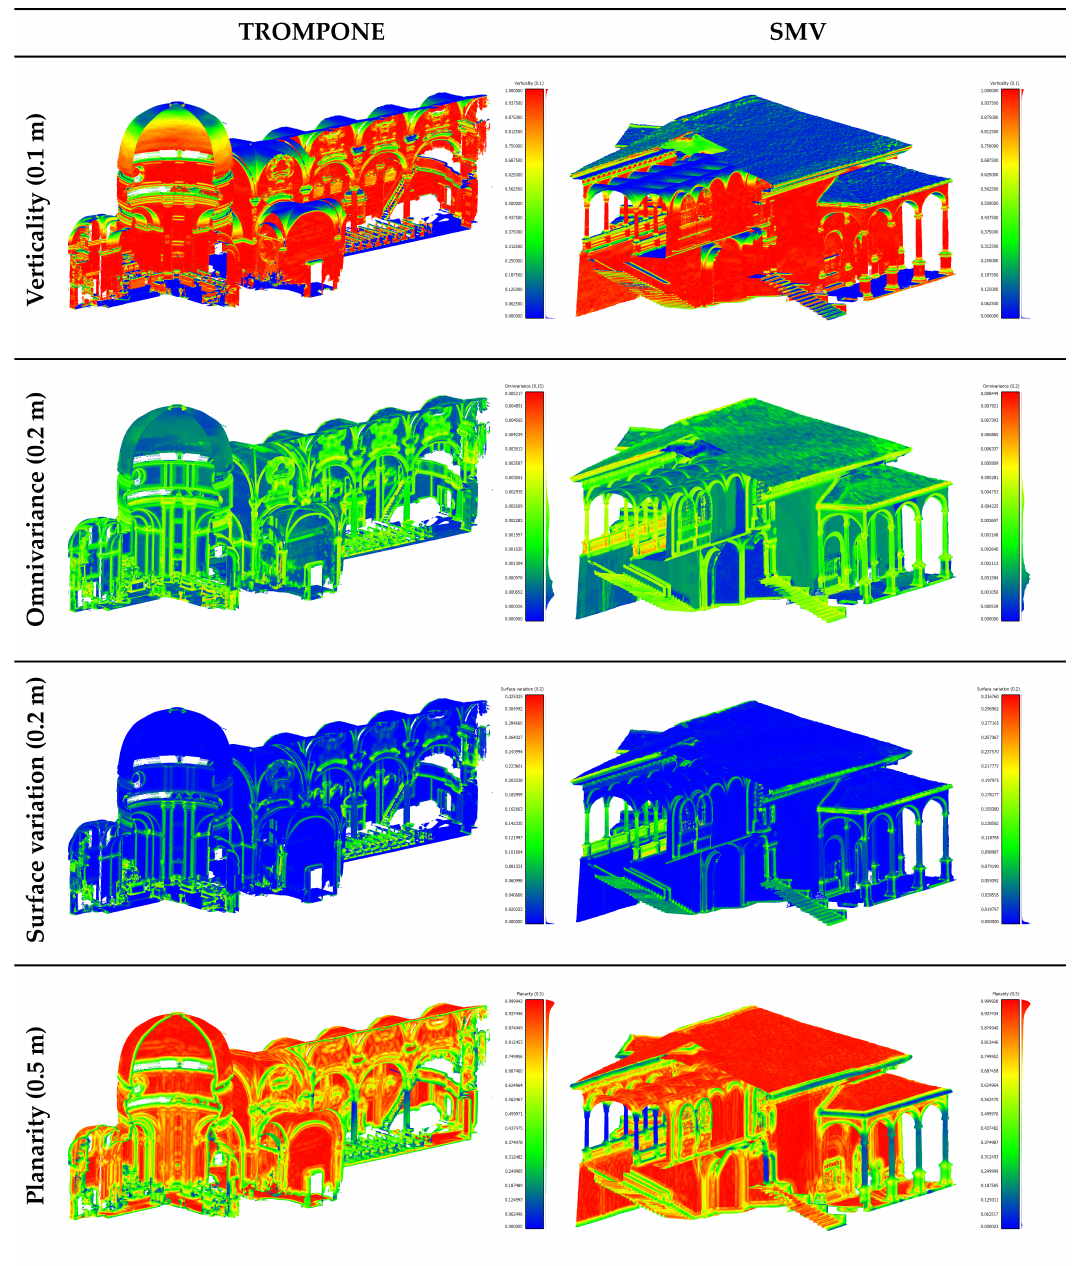
Figure 2. Three-dimensional features used to train the ML and DL classifiers. The colour of the plot represents the feature scale. The used search radii are reported in